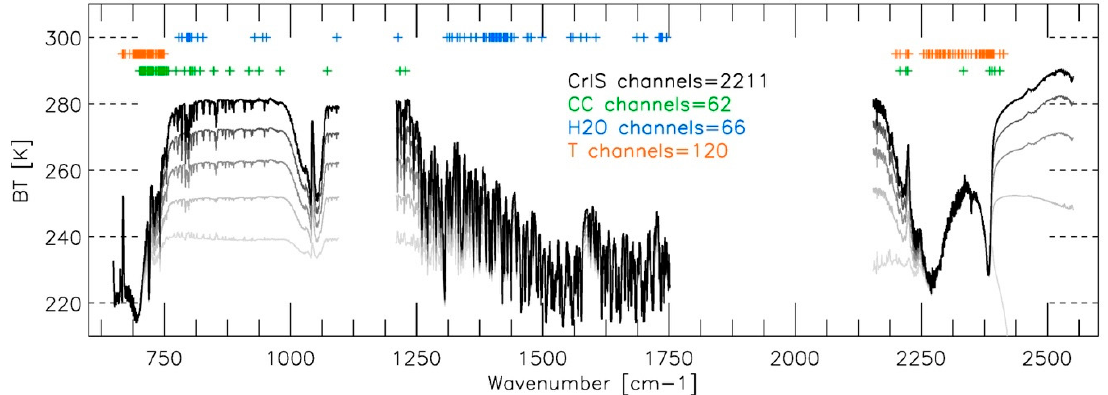
Figure 2. Cross-track Infrared Sounder (CrIS) brightness temperature (BT) spectra for five different atmospheric states varying in percent cloud cover from black to light grey as follows: 0%, 20%, 40%, 60% and 80%. CLIMCAPS employs a subset of channels in the retrieval of each ECV to linearize the inversion problem, maximize information content and minimize scene-dependent uncertainty. Here we show the channel subsets for the three CLIMCAPS ECVs discussed in this paper, namely, 62 channels for cloud properties (green), 66 channels for water vapor (blue) and 120 channels for temperature (orange ) .